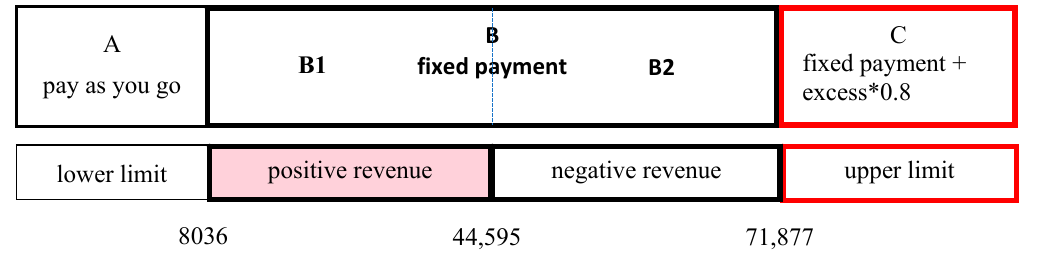
Figure 2. Execution of the TW-DRG medical payment system in hospitals.